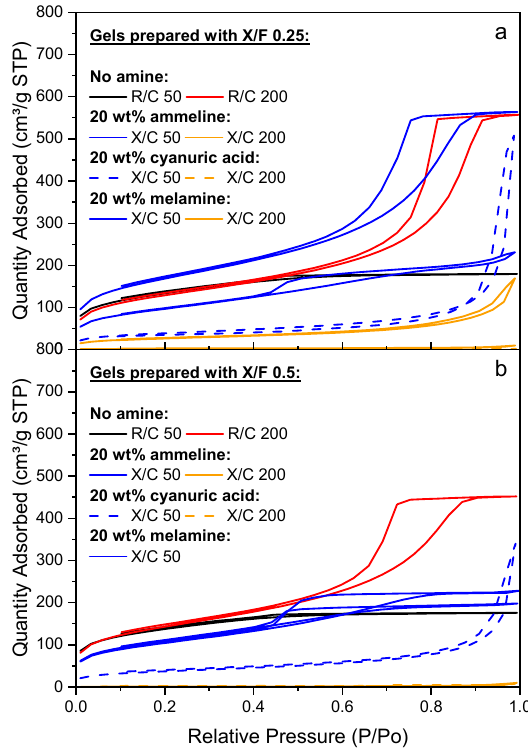
Figure 9. Nitrogen sorption isotherms for gels prepared with 20 wt% of additives and with ( a ) X / F 0.25 and ( b ) X / F 0.5.